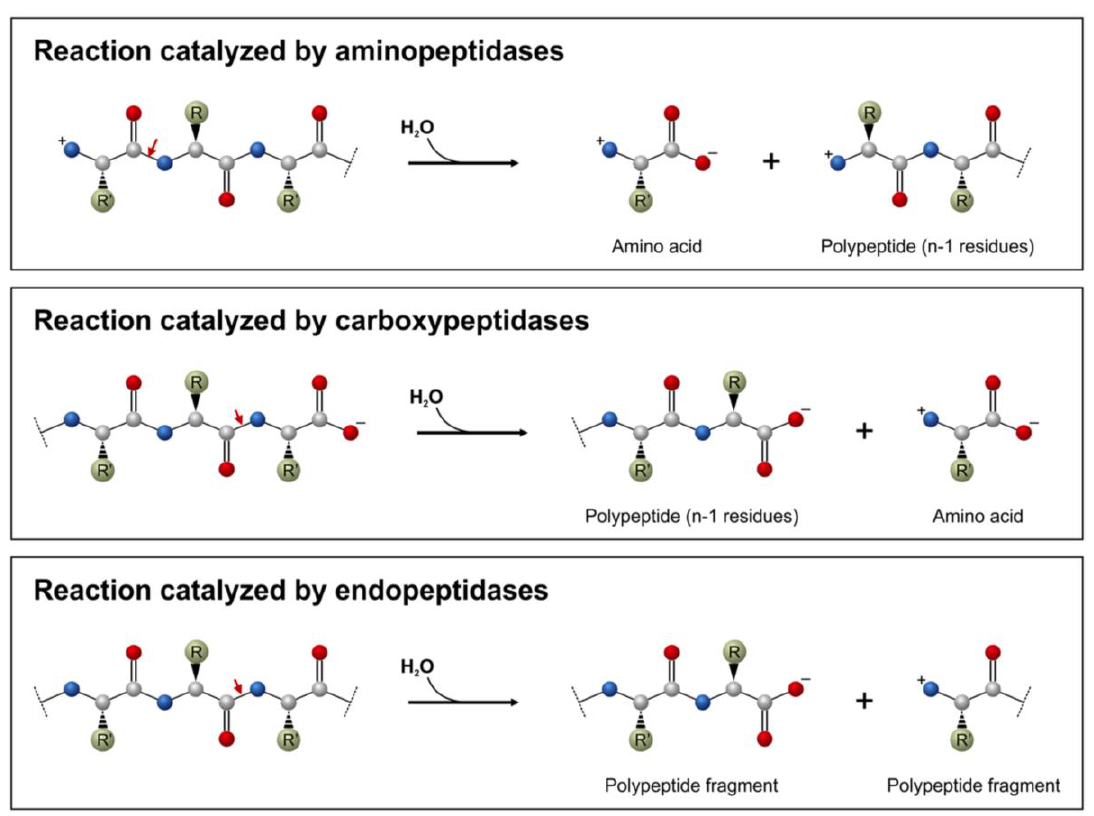
Figure 1. Action of aminopeptidases and carboxypeptidases removing the terminal amino acid residues as well as endopeptidases on a polypeptide substrate (having n residues). Red arrows show the peptide bonds to be